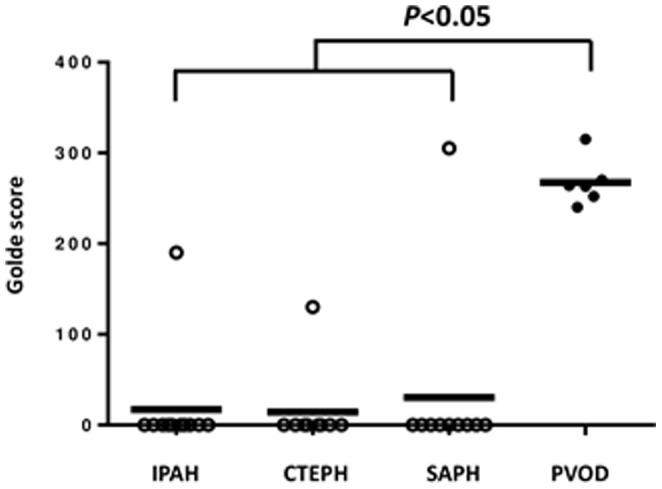
Haemosiderin-laden macrophages are significantly (P<0.05) more present in sputum from PVOD patients as compared to the others (IPAH, CTEPH and SAPH, respectively).